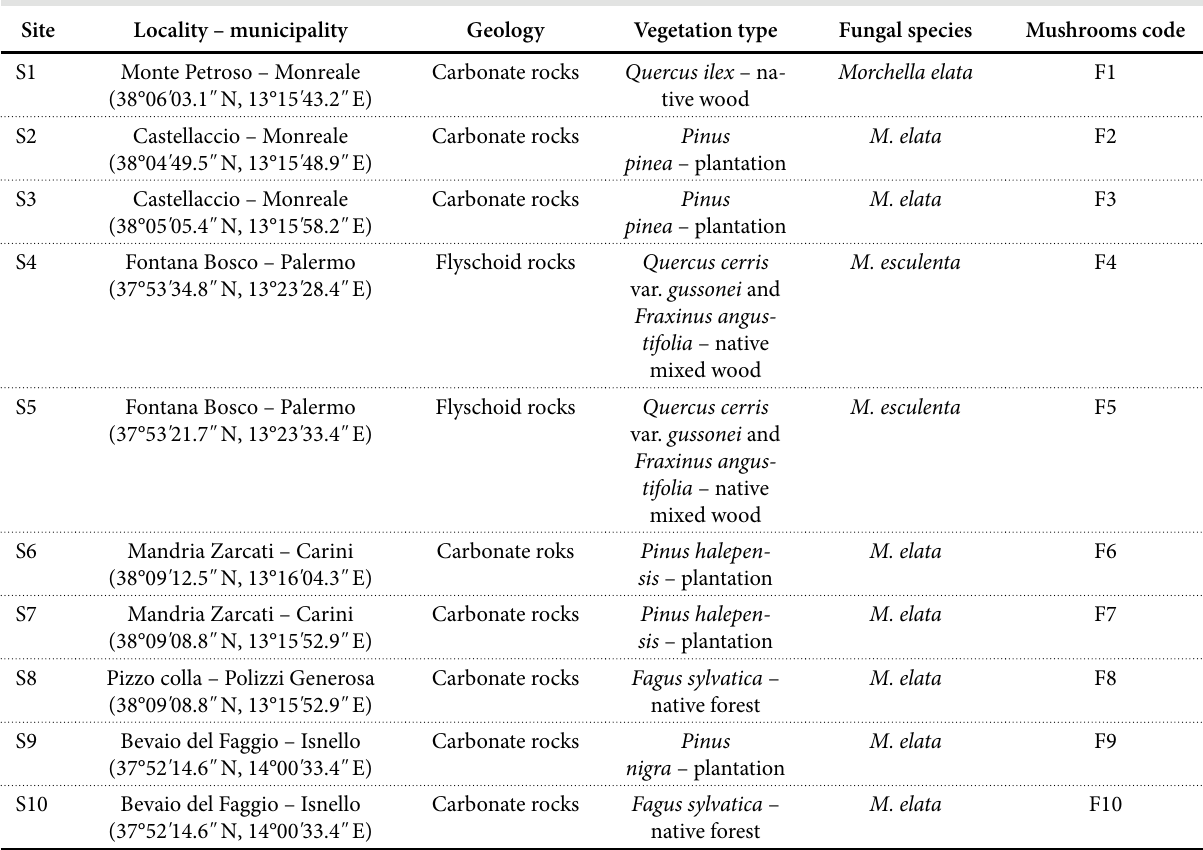
Tab. 1 Details of the study sites: code, locality with GPS coordinates, geology, and vegetation type. Fungal species and their cor- responding codes are detailed in the last two